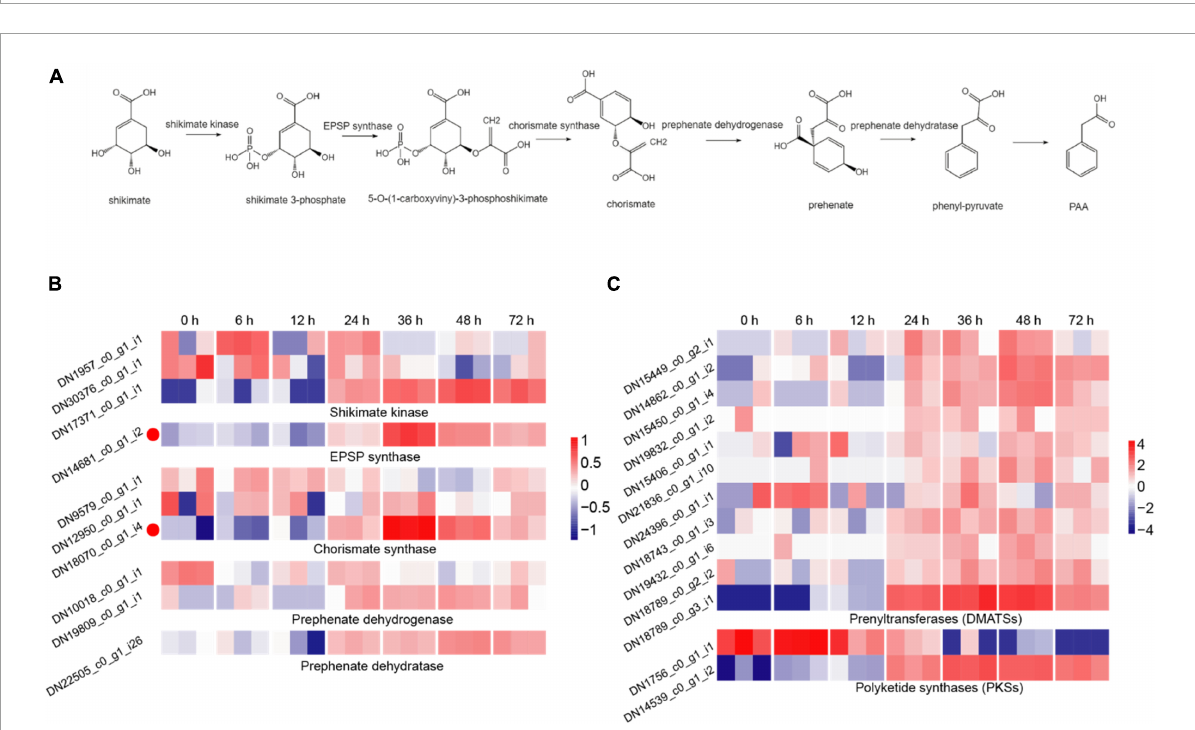
Glycoside hydrolases (GHs), Glycosyl transferases (GTs), Polysaccharide lyases (PLs), Carbohydrate esterases (CEs) and Carbohydrate-binding modules (CBMs) (Cantarel et al., 2009).